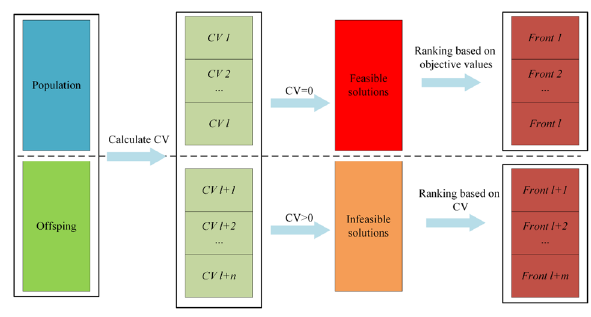
Fig. 2 Ranking procedure using CDP